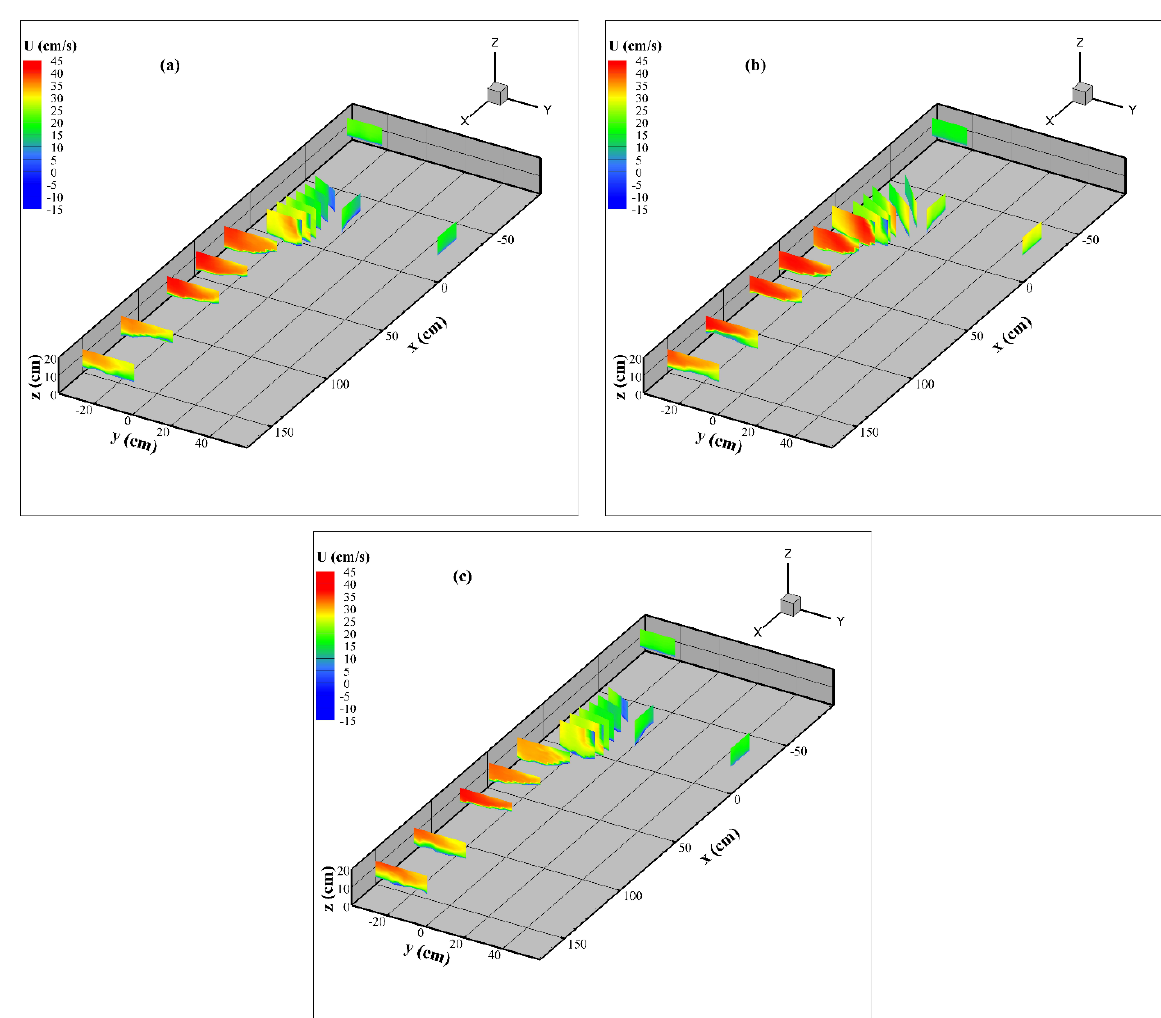
Figure 4. The spatial distribution of streamwise velocities U of three cases. ( a ): case 1; ( b ): case 2; ( c ): case